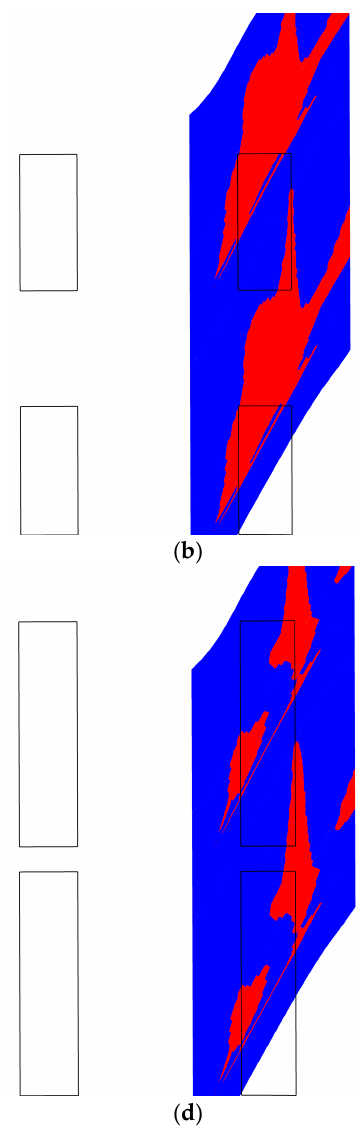
Figure 21. Contour distribution of the blockage area at 99% blade span. ( a ) SW. ( b ) SRCC0.36. ( c ) SRCC0.54. ( d ) SRCC0.72. ( e ) SRCC0.9.